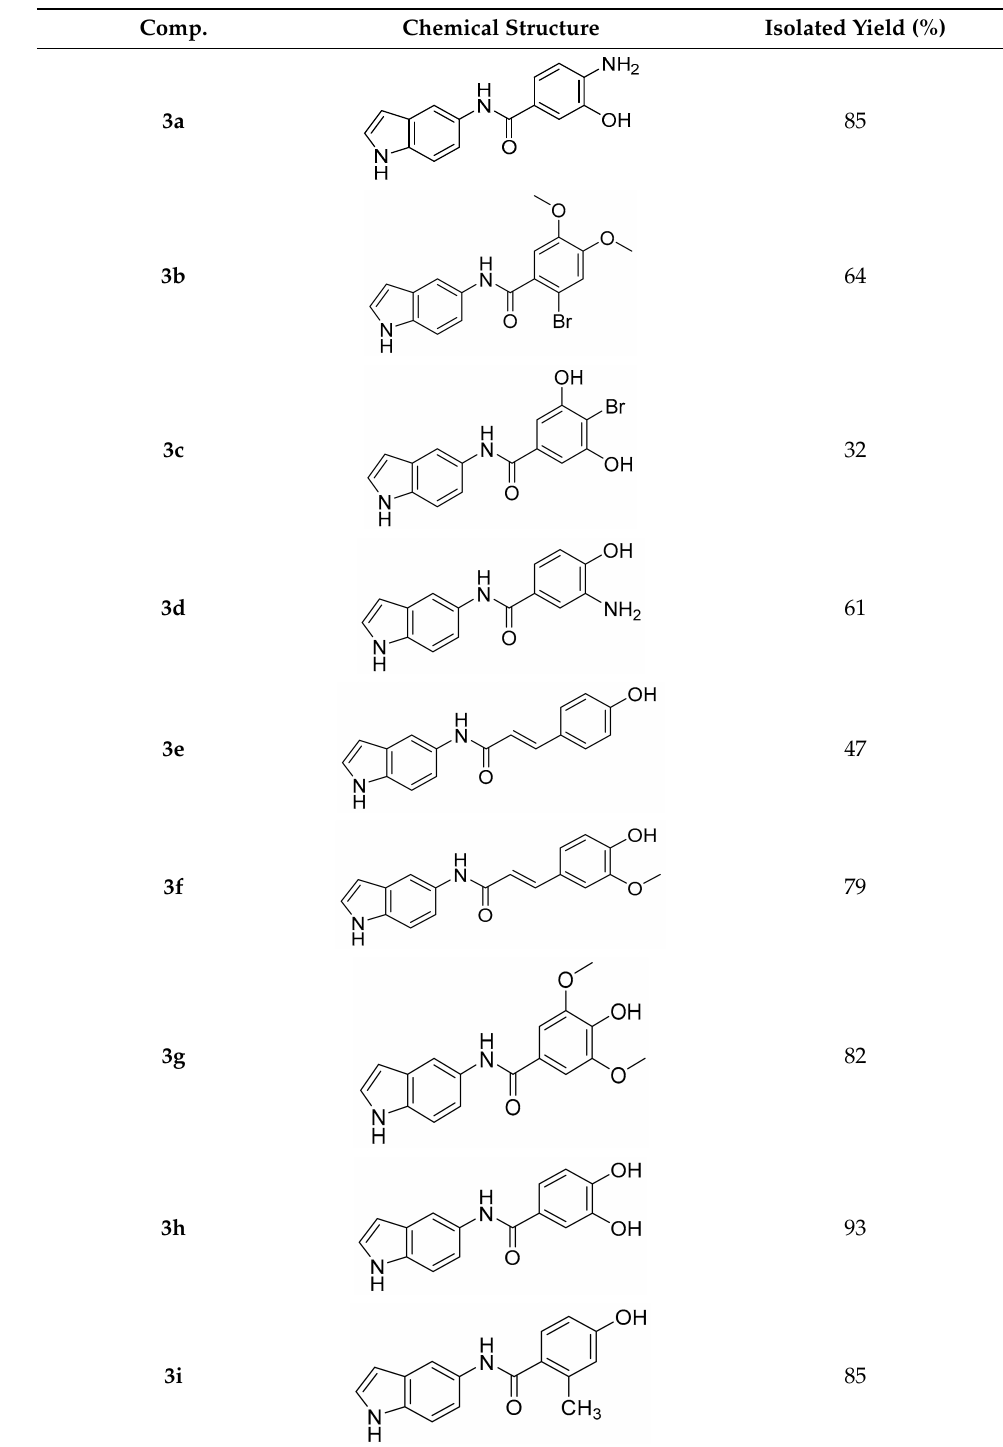
4 of 16 Figure 2. Design of structural hybridization of the caffeic acid derivatives with melatonin scaffold, in addition to the synthetic planning, to obtain the novel indole–caffeic amide analogues 3a ‒ m . 2. Materials and Methods 2.1. Chemical Reagents, Purification, and Instrumentation The general protocols utilized for the chemical synthesis, structure elucidation, and purity of the newly synthesized indole–caffeic acid hybrids are provided in the supple- mentary file.